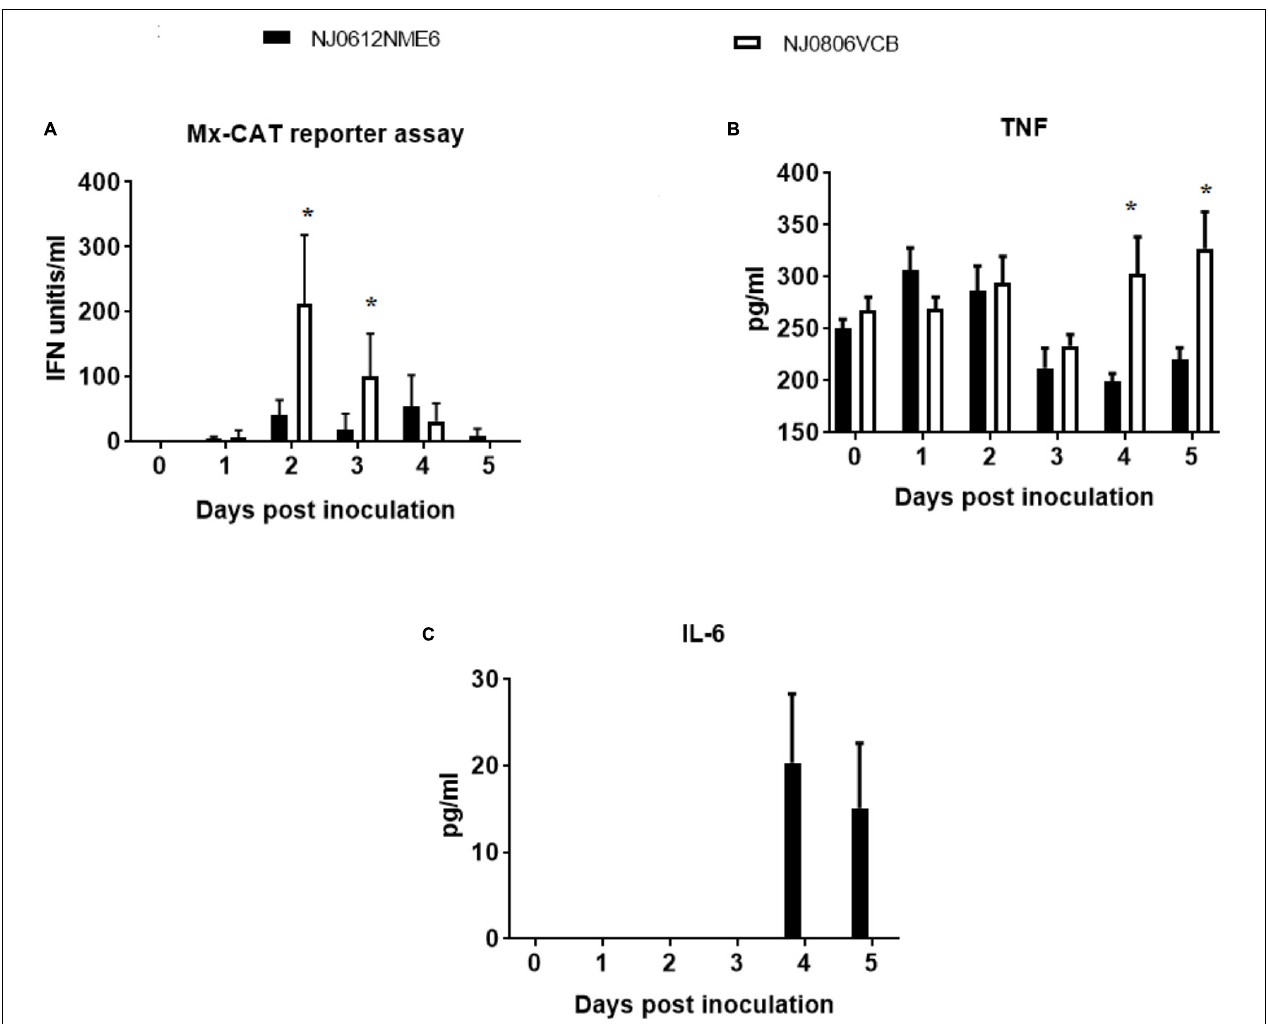
FIGURE 12 | Innate immune response following infection in pigs with NJ0612NME6 or NJ0806VCB. Serum samples collected from inoculated during the acute phase of the infection was used to evaluate: (A) Type I IFN antiviral activity by MX-CAT reporter assay, (B) tumor necrosis factor (TNF), and (C) interleukin 6 (IL-6) by ELISA. Significantly different values ( p < 0.05) between groups are indicated with asterisks ( ∗